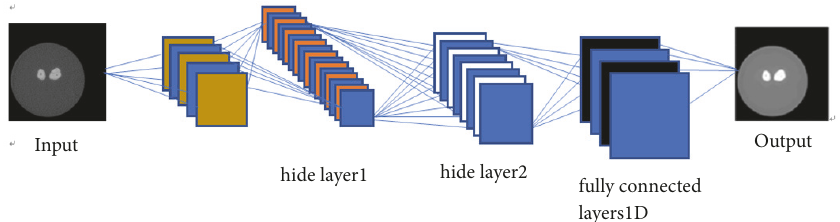
Figure 1: The architecture of the MLP